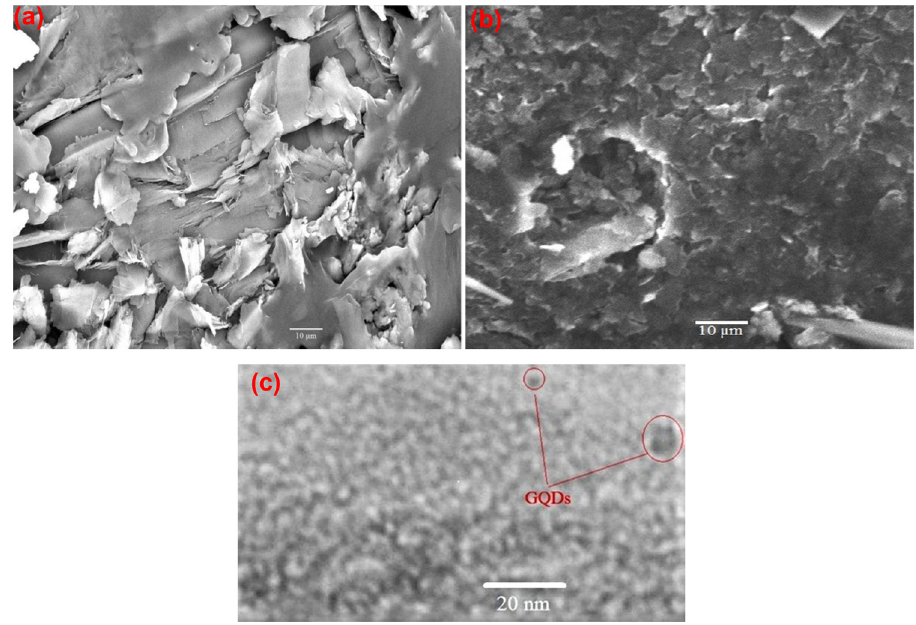
Figure 3: ( a ) SEM image of the bare CPE, ( b ) SEM image of the poly ( r - o - NBA ) /GQDs/CPE, and ( c ) TEM image of the poly ( r - o - NBA ) /GQDs/CPE.